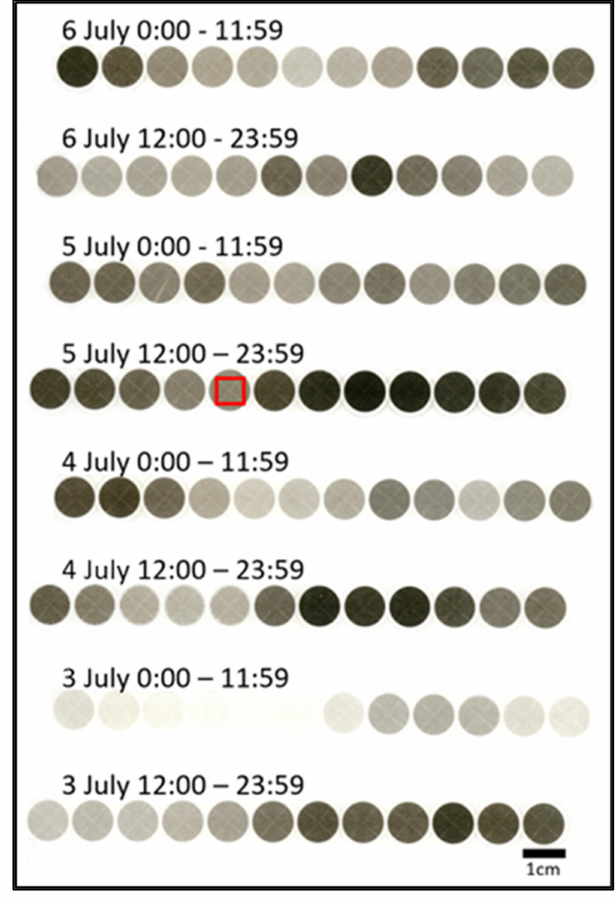
Figure 3. An example of the filter samples used for the Image J analysis. The red square shows how the samples were measured and all the times are indicated in Chilean standard local time